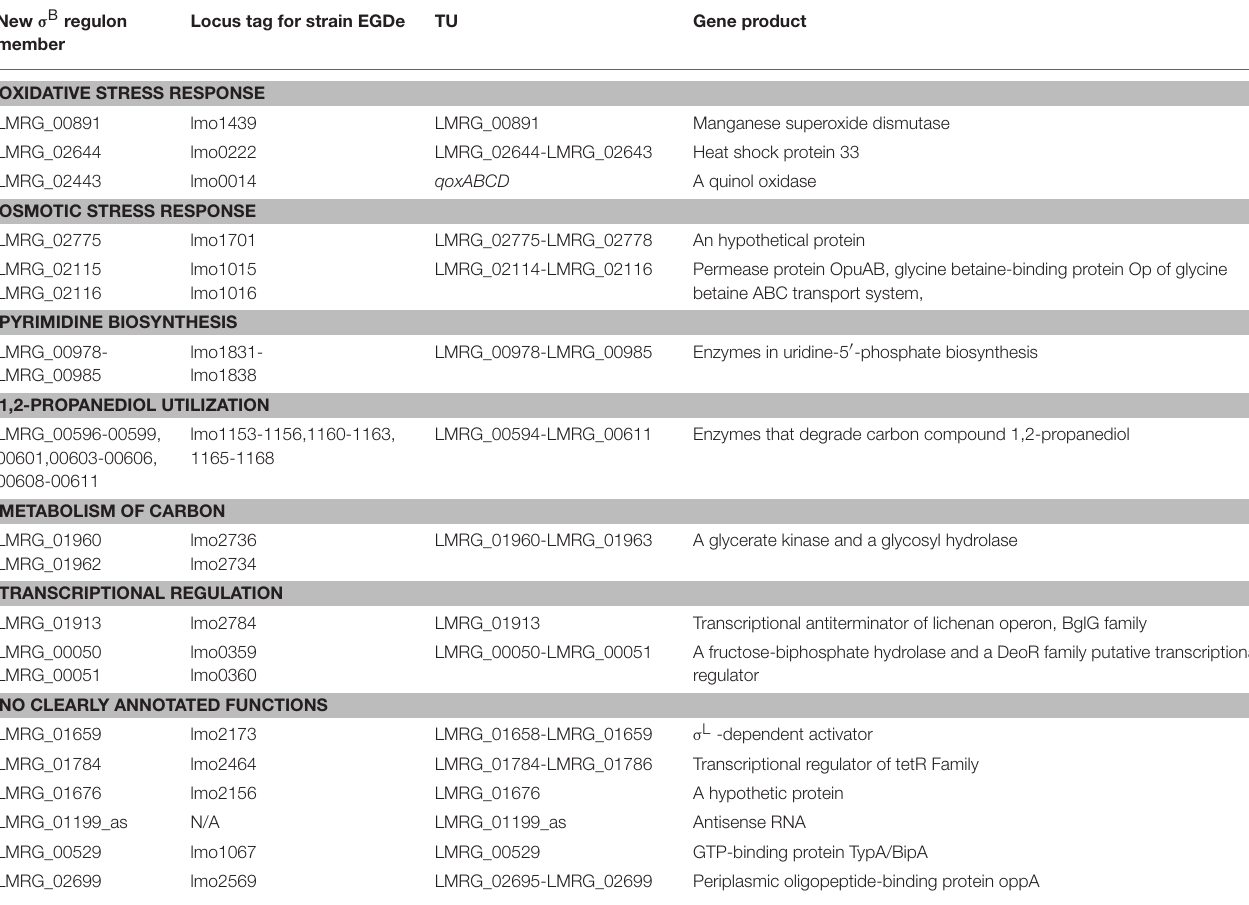
TABLE 2 | Newly identified σ B regulon members grouped by function. New σ B